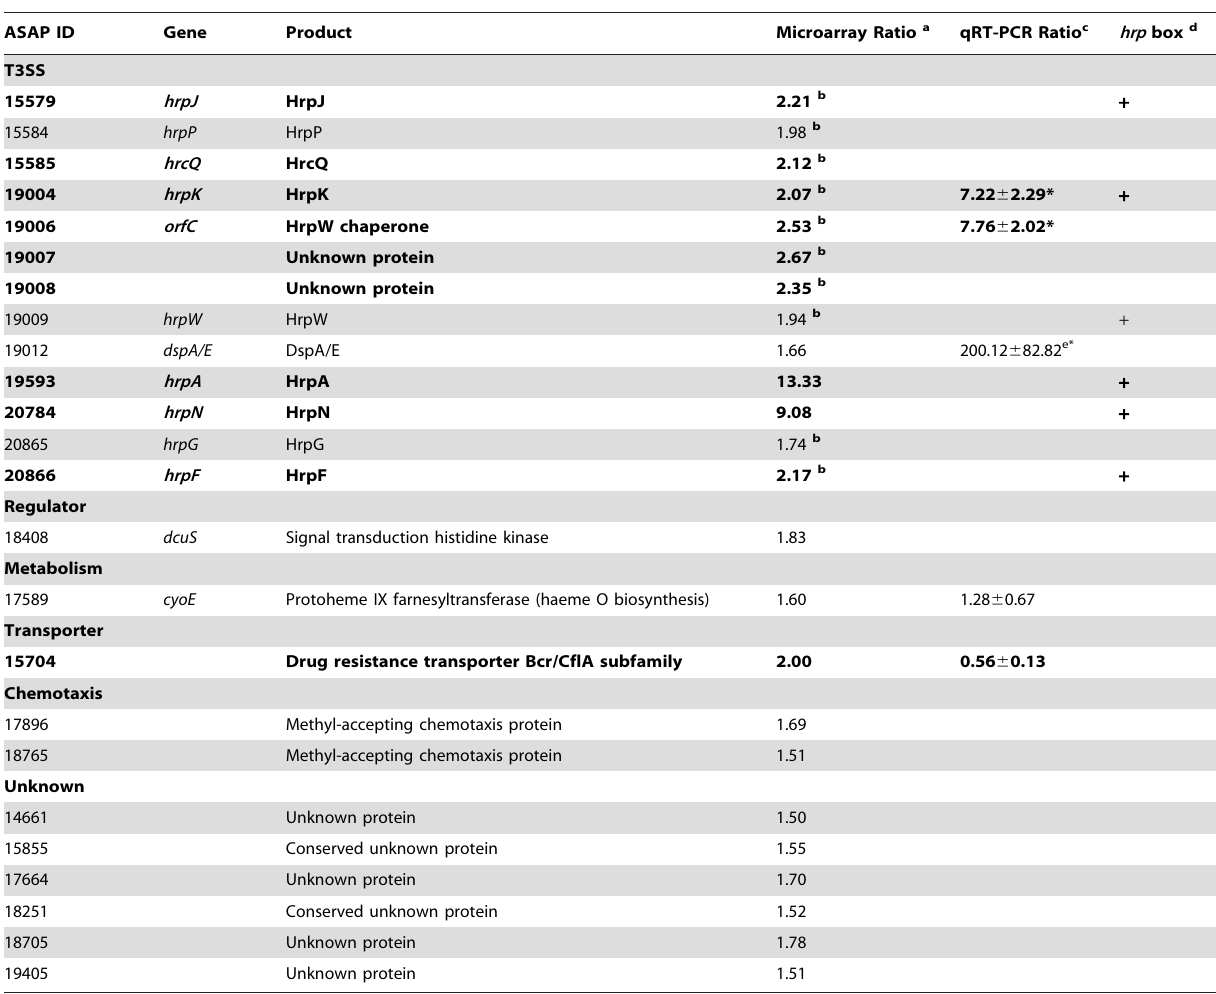
Table 1. HrpL up-regulated genes in Dickeya dadantii